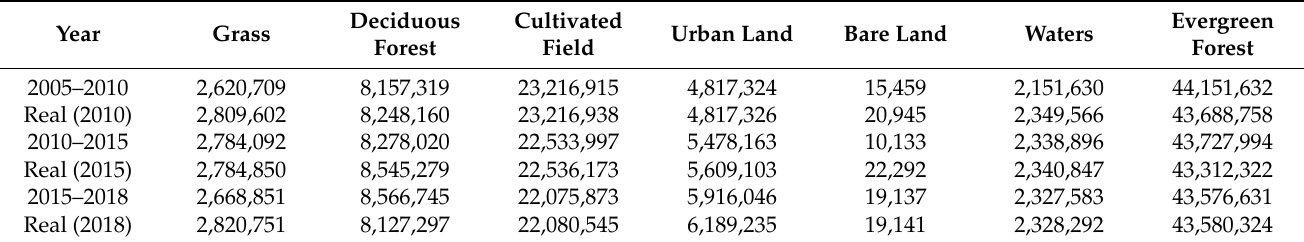
Table 3. Comparison of the area of the land use type simulation and the real land use type in 2010, 2015, and 2018 (km 2